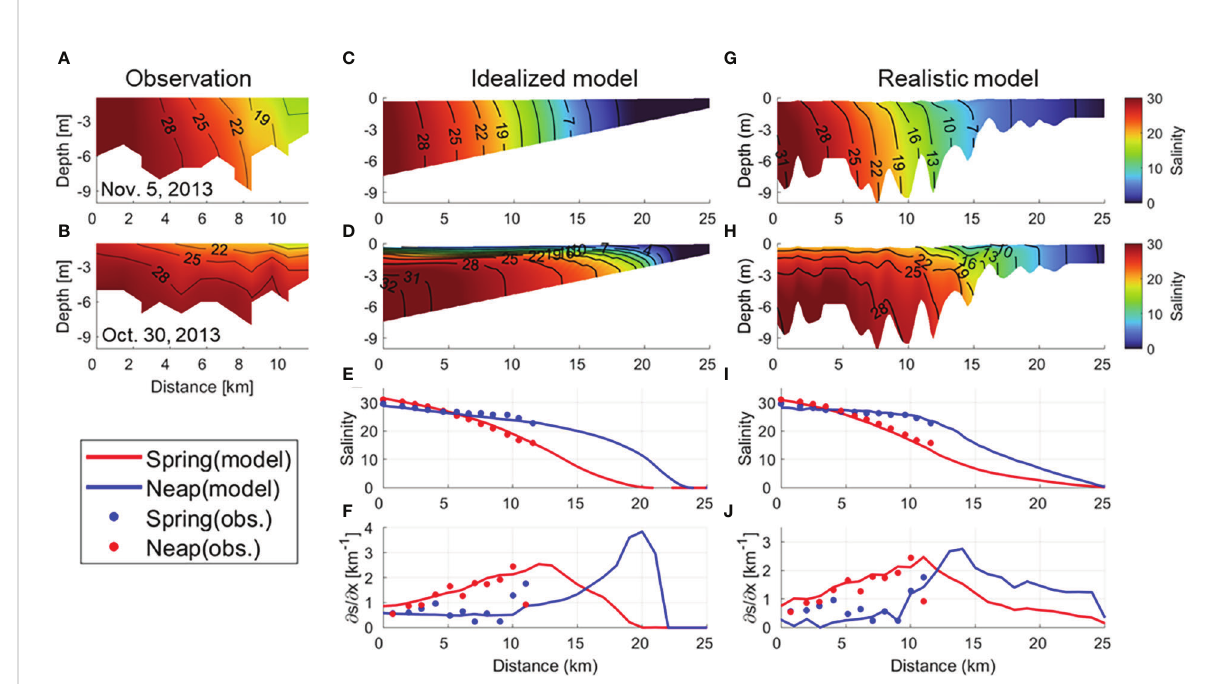
FIGURE 3 Comparisons of salinity among observations, an idealized model, and a realistic model. Vertical sections of the along-channel salinity during (A, C, G) the spring tide and (B, D, H) neap tide in (A, B) observations, (C, D) the idealized model and (G, H) , and the realistic model. Variations in depth-averaged (E, I) salinity and (F, J) horizontal salinity gradient from mouth to head during spring (red) and neap tides (blue). Dots and lines denote observations and model outputs,